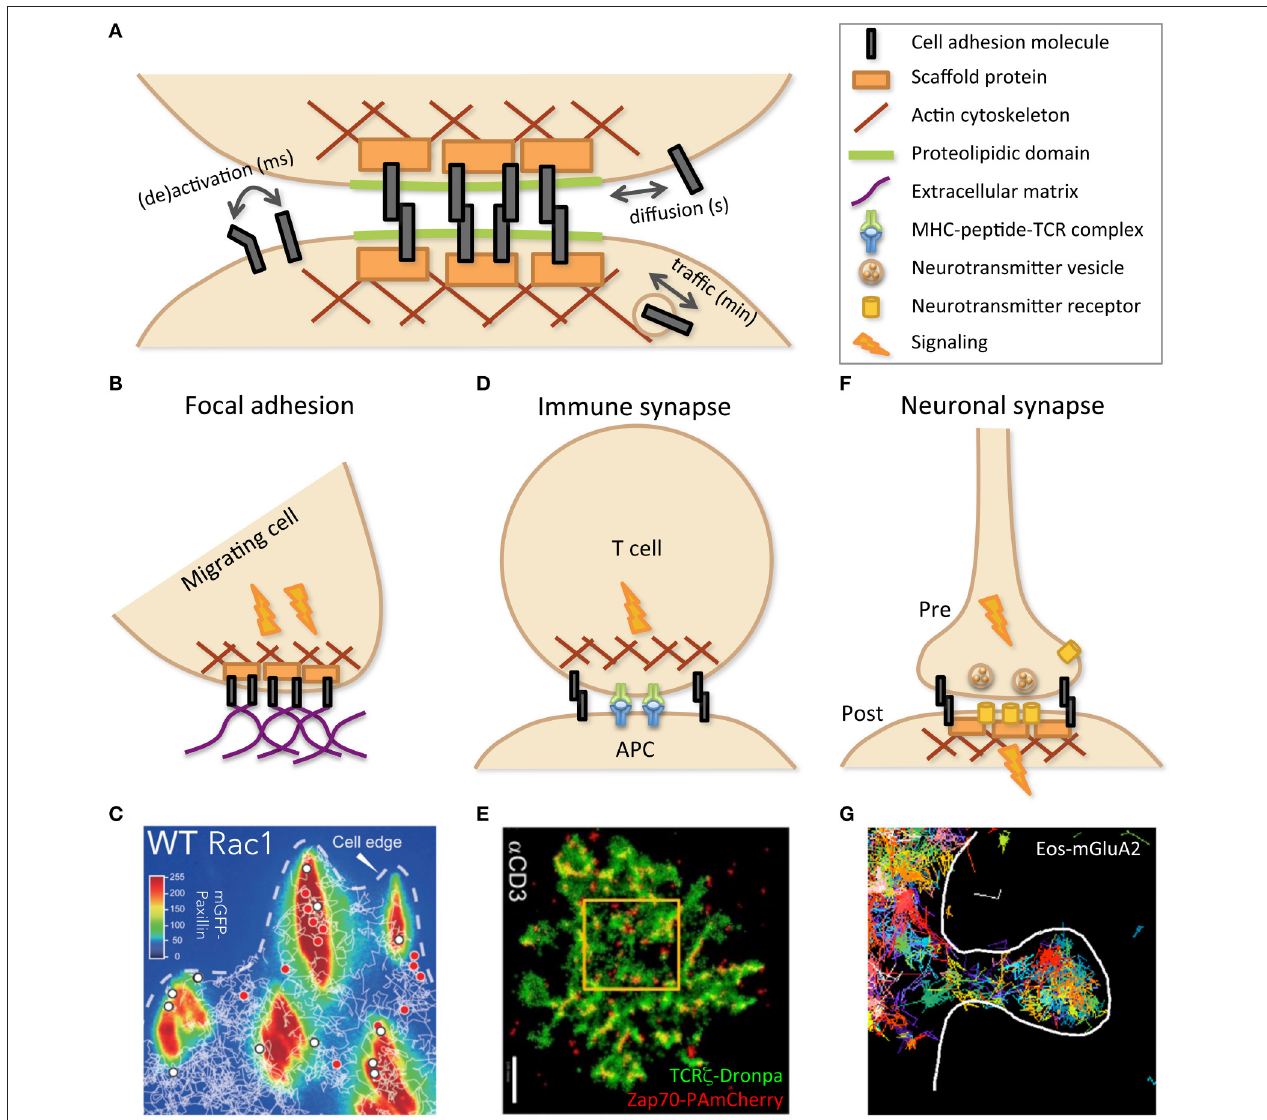
FIGURE 1 | Cell–cell adhesion is mediated by specific molecular structures. (A) Schematic representation of the building blocks involved in cell–cell contacts. Dynamic evolution, as indicated by double arrows, may occur on various time scales, through changes in molecular conformation, such as activation, and localization, both within the membrane, by diffusion, and within the cell, by vesicular traffic. As depicted by cartoons (B,D,F) and illustrated by experimental data (C,E,G) , specialized cell contacts can be implicated in structures such as focal adhesion (B,C) , immune (between T cell and APC; D,E ), and neuronal (between pre- and post-synaptic neurons) synapses (F,G) , dealing with specific dynamics in relation with their function. (C) Trajectories of wild-type (WT) Rac1, tagged with Halo-tetra-methyl-rhodamin, obtained by single-particle tracking (white lines) and superimposed on mGFP-Paxillin staining (false colors identifying FAs) reveal transient (red dots) or stable (white dots) immobilization within FAs. Reprinted from Shibata et al. (2013). (E) PALM imaging was performed with two molecules of the TCR complex, tagged with photoactivatable fluorescent proteins, TCR ζ –Dronpa and ZAP-70-PAmCherry, in an E6.1 Jurkat cell on α CD3-coated coverslip. Nanoscopy of the immune synapse reveals TCR micro- and nano-clusters (green) with ZAP-70 sub-clusters (red) associated to activated TCR. Bar: 2 µ m. Reprinted from Neve-Oz et al. (2015). (G) Trajectories of the tagged AMPA receptor Eos-GluA2 measured by sptPALM report transient organization in nanodomains within an excitatory dendritic spine (delimited by the white line) of a rat hippocampal neuron. Reprinted from Nair et al.